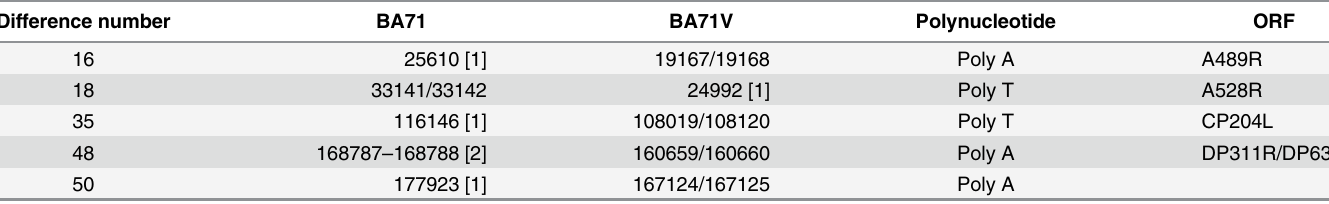
The position of the differences in each genome is indicated along with the size of the change, in brackets. The nature of the polynucleotide and the ORF affected, if any, are also